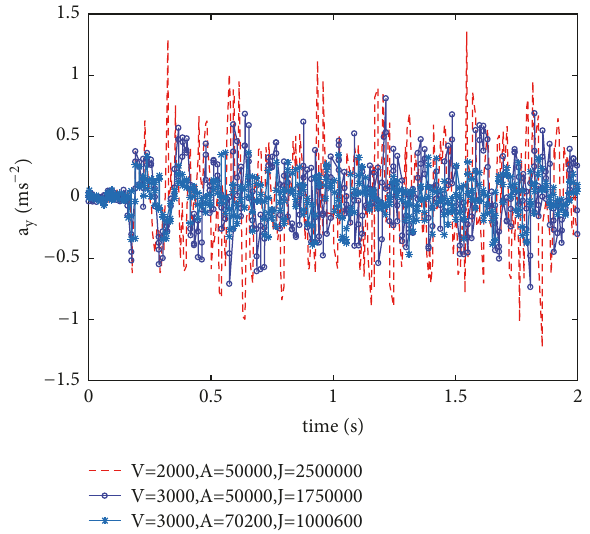
Figure 18: Waveforms of the comparative group of